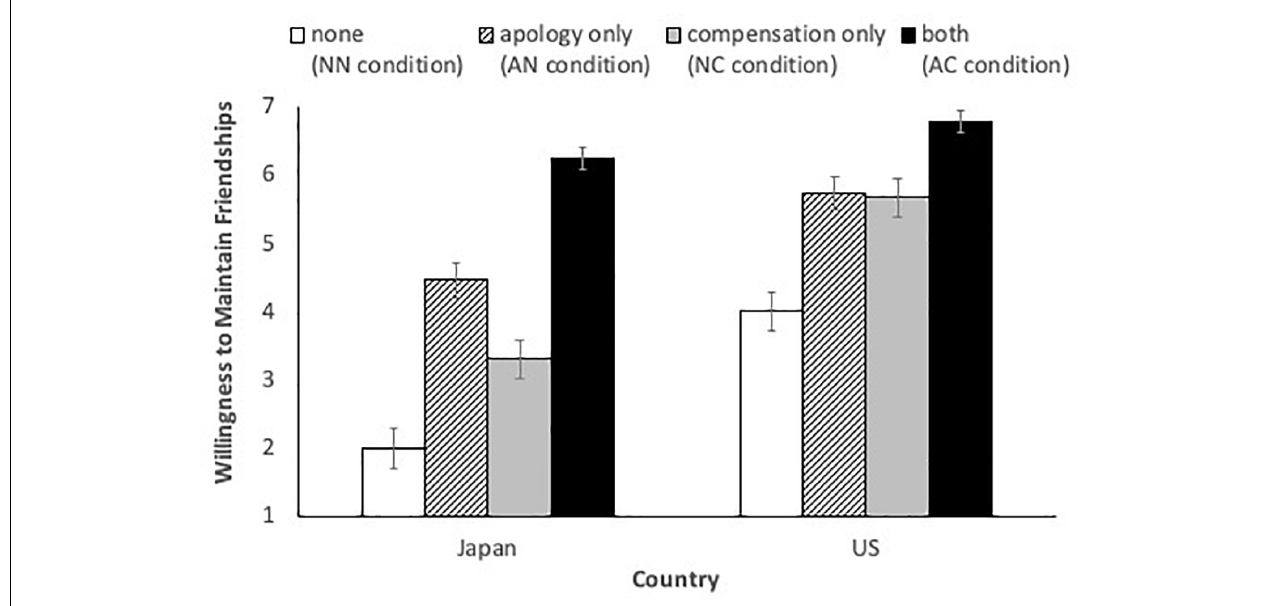
FIGURE 1 | The means and 95% confidence intervals (95% CI) of willingness to maintain friendships in each condition (Study 1). Error bars represent 95% CIs.